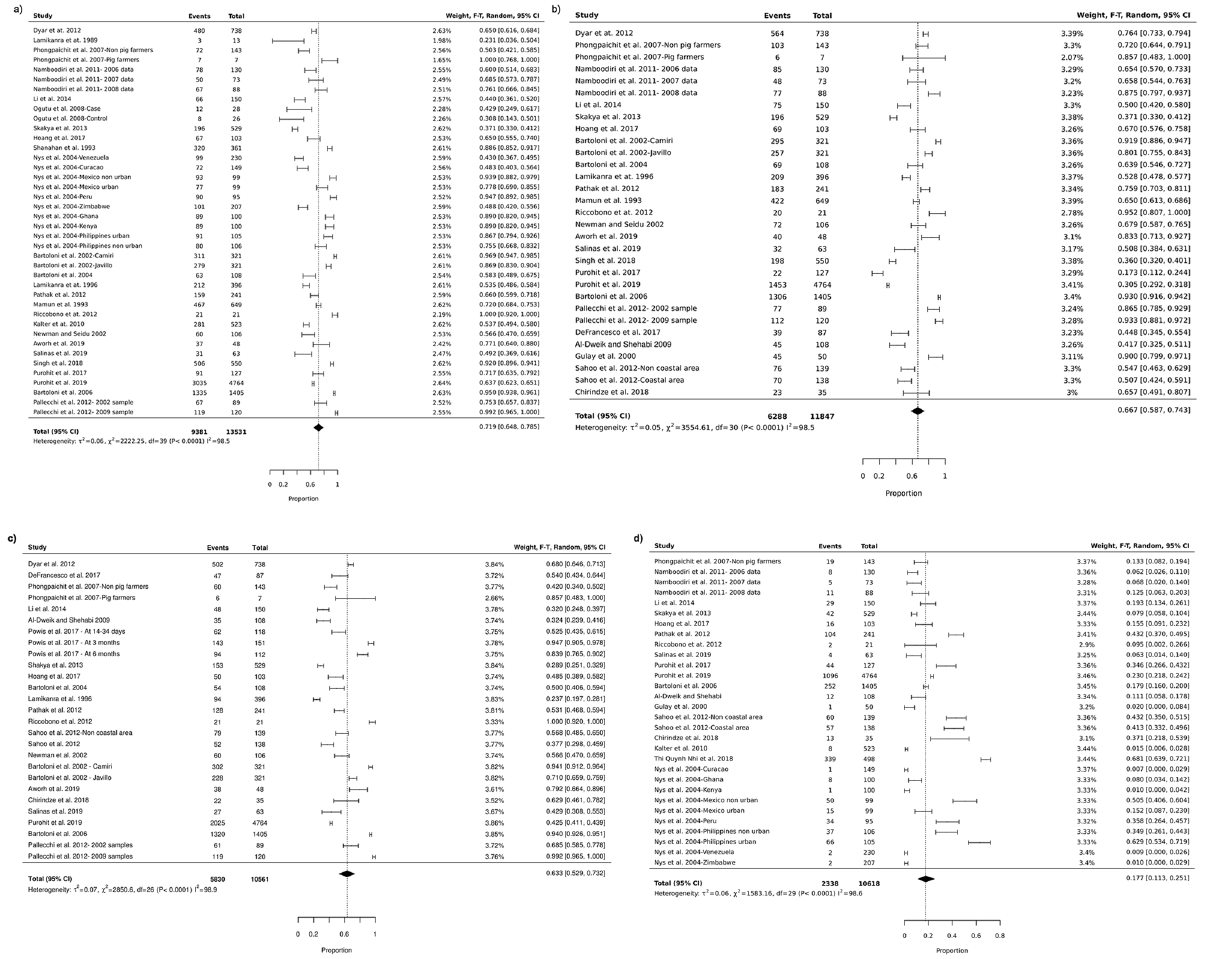
Figure 4. Forest plots showing the prevalence of antibiotic resistance in commensal E. coli isolated from human sources in community settings in low- and middle-income countries. (a) Cell wall synthesis inhibitor (ampicillin), (b) protein synthesis inhibitor (tetracycline), (c) folate synthesis inhibitor (co-trimoxazole), and (d) nucleic acid synthesis inhibitor